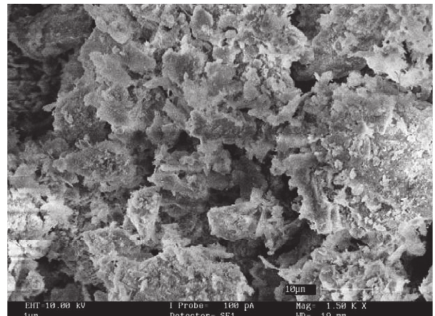
Figure 8: SEM analysis of soil matrix stabilized with 4% cement and 8%